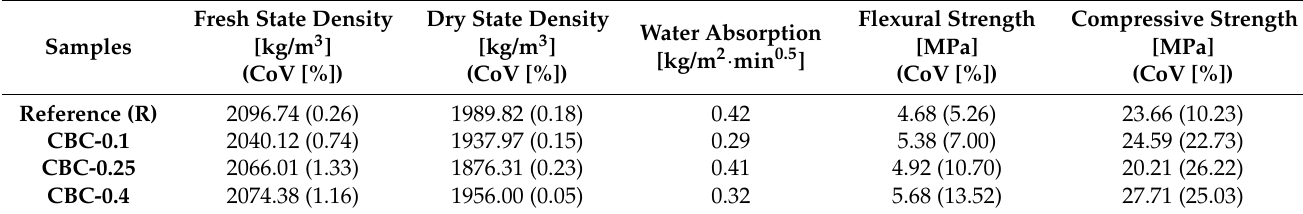
Table 7. Summary table with all the test results obtained for cement